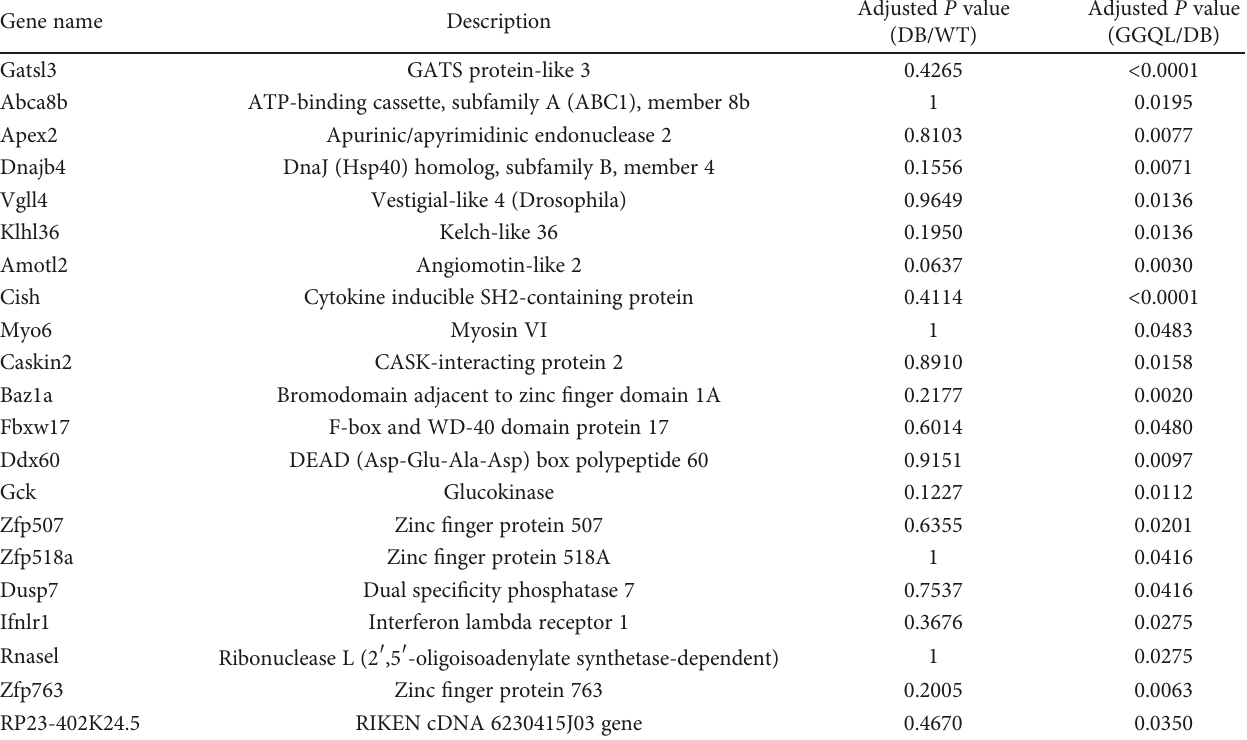
Table 3: Genes signi fi cantly regulated in the GGQL group versus the DB group but no di ff erential expression in the DB group versus the WT